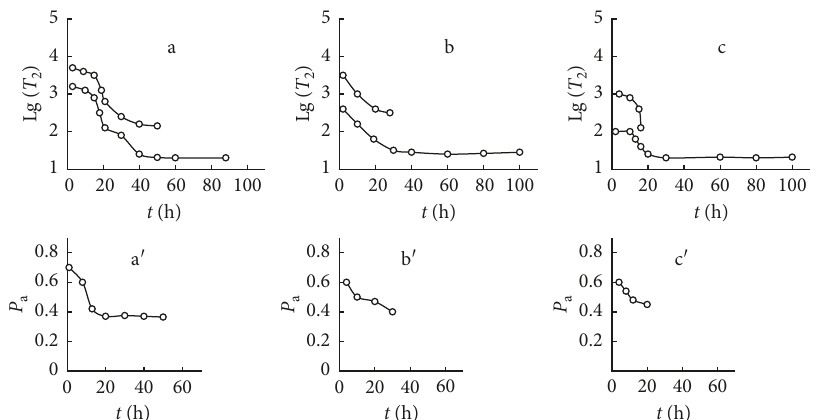
Figure 5: Change in the transverse relaxation times (a–c) and the population of the mobile “phase” protons (a 20+DCC/ED-20 +DETA composition with a content of DCC/ED-20: 10% (a, a ), 20% (b, b